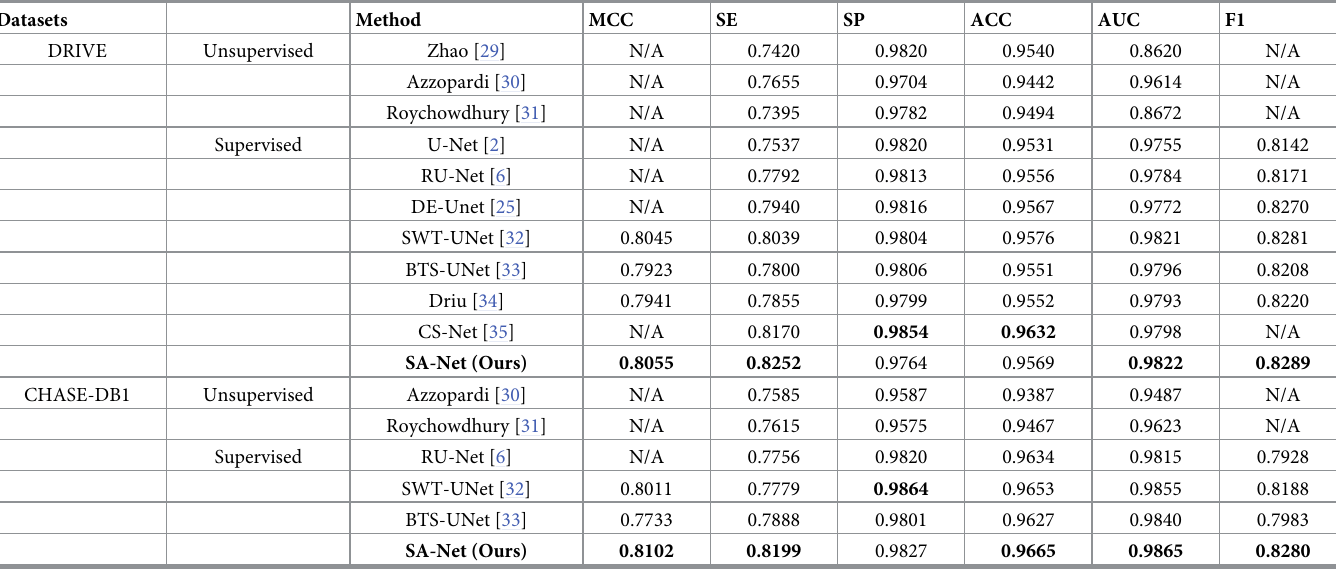
Table 1. Segmentation performance metrics on two publically available retinal image datasets.